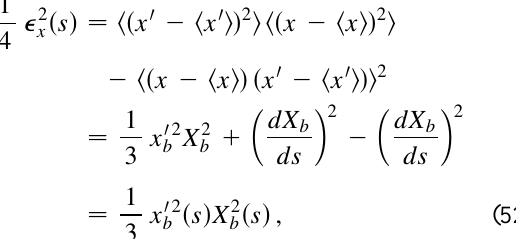
for the choice of distribution function in Eq. (40).